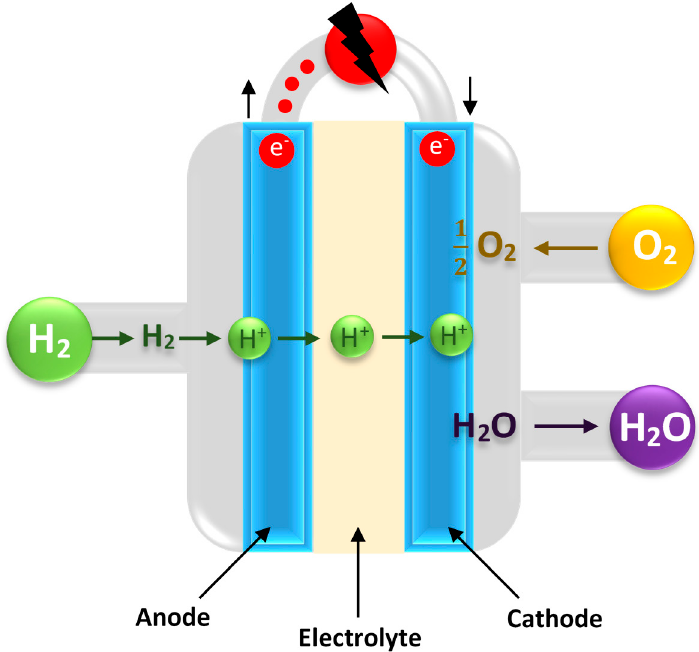
Figure 1. The construction and operation of a fuel cell.